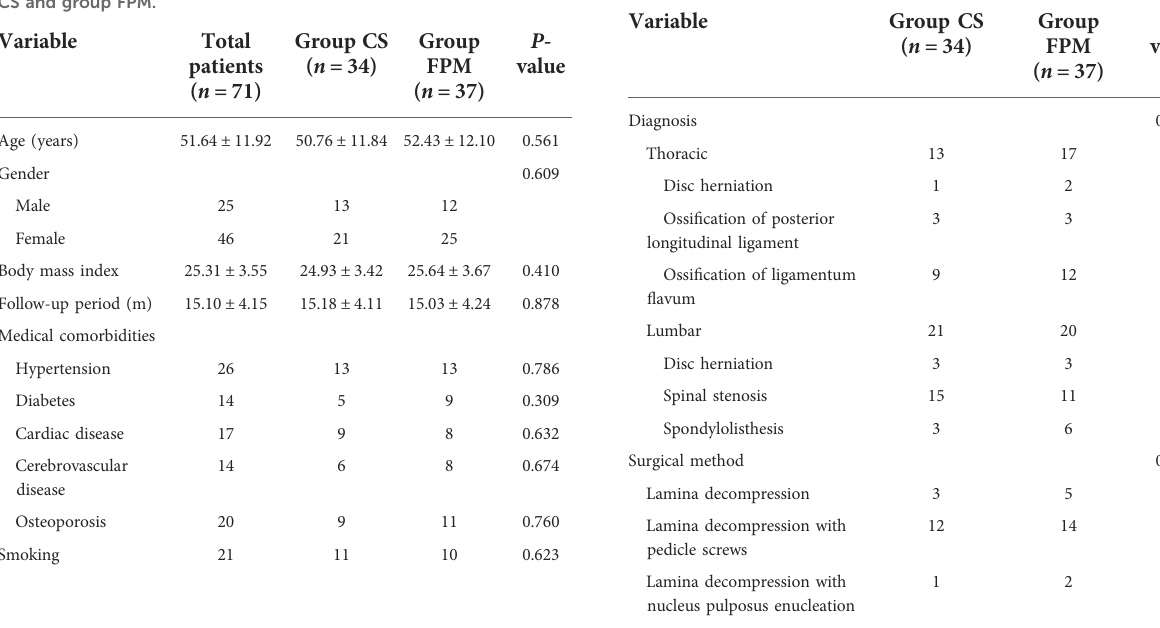
TABLE 2 Diagnosis and surgical date in group CS and group FPM.